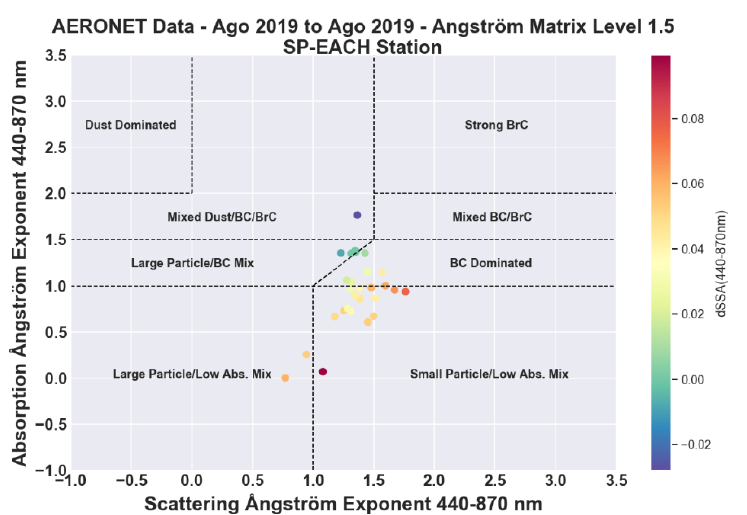
Figure 13. Dispersion diagram of Scattering Ångström Exponent by Absorption Ångström Exponent (Ångström Matrix Level 1.5). Ångström Exponent retrieved from AERONET sunphotometer measurements in São Paulo city (23°48 ′ S, 46°49 ′ W, 754 m asl) during August 2019. BrC, BC, and Abs indicate Brown Carbon, Black Carbon, and Absorption, respectively.